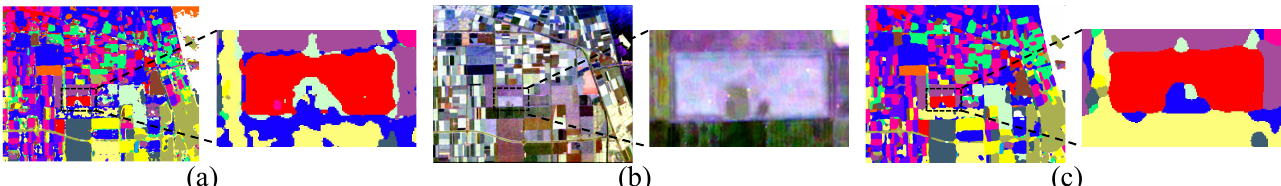
Figure 11. Enlarged classification results of the Peas region on AIRSAR Flevoland dataset. ( a ) 2D-CNN. ( b ) Pauli RGB image. ( c ) Proposed method.